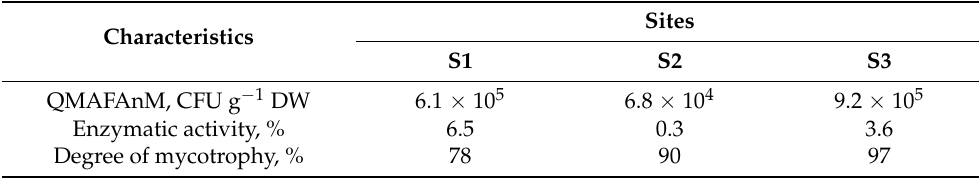
Table 4. The characteristics of rhizospheric microbiota of E. atrorubens from studied sites. Characteristics